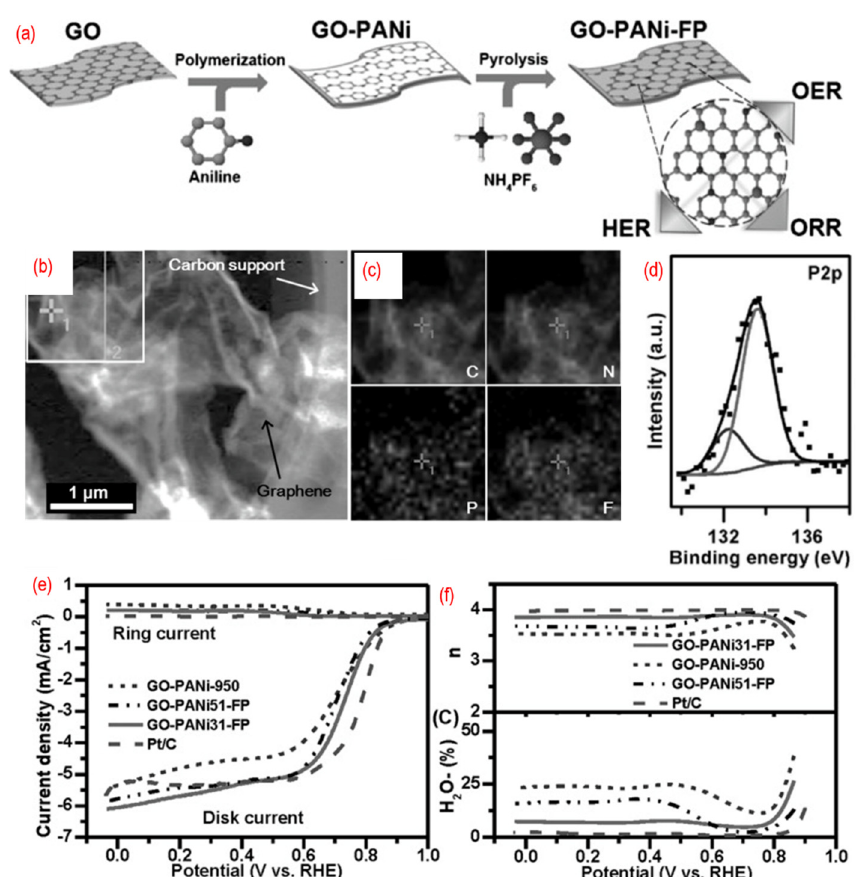
Figure 8. ( a ) The schematic of the synthesis process, ( b ) the TEM image, ( c ) C-, N-, F-, and P-elemental mappings, ( d ) the high-resolution P 2p peaks, ( e ) the activity test (LSV curves recorded by RRDE in O 2 -saturated 0.1 M KOH solution with 1600 rpm at a scanning rate of 10 mV s − 1 ), ( f ) the electrons transfer number and H 2 O 2 yield of N, P, F-graphene. Reproduced from [92]. © 2022 WILEY-VCH Verlag GmbH & Co. KGaA, Weinheim.